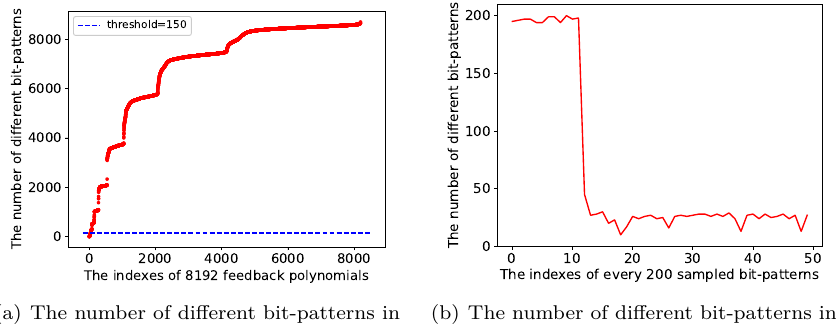
Figure 6: The measured results of the number of different